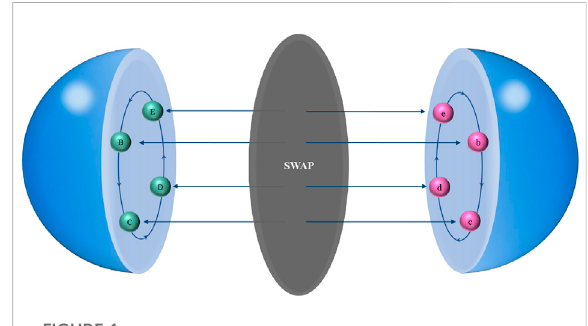
In this fi gure, there are three corresponding layers: the left hemisphere layer is the quantum ramble, right is the error- correcting code, and middle SWAP gate is the exchange gate. The greenB → E → Bnodeontheleftisthequantumwalkprocess andcorrespondstotheerrorcorrectioncodeofthepinkb-enode on the right. When the particles are in a quantum walk, they are swapped through SWAP gate to the lower network to correct errors and then switched back to the original